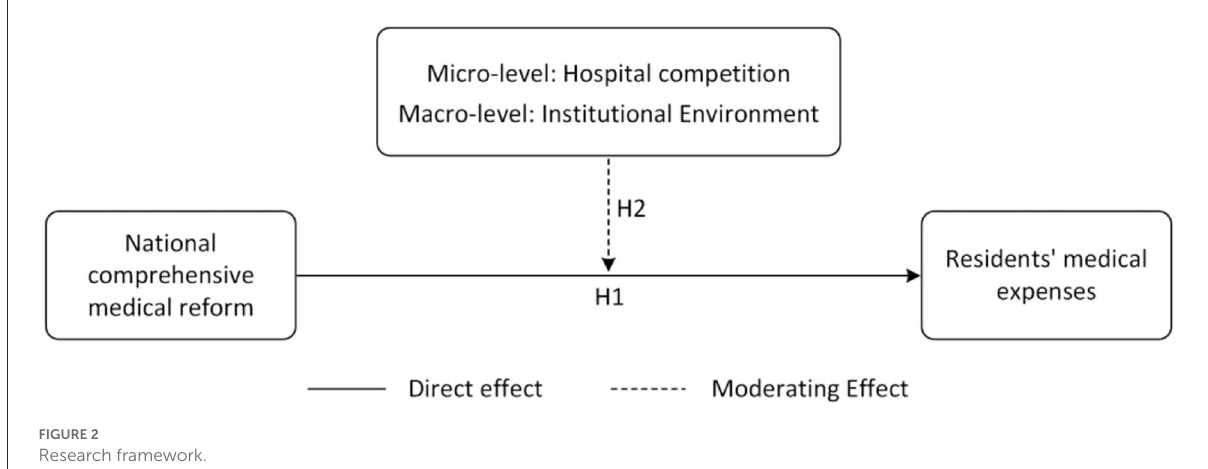
FIGURE2 Research